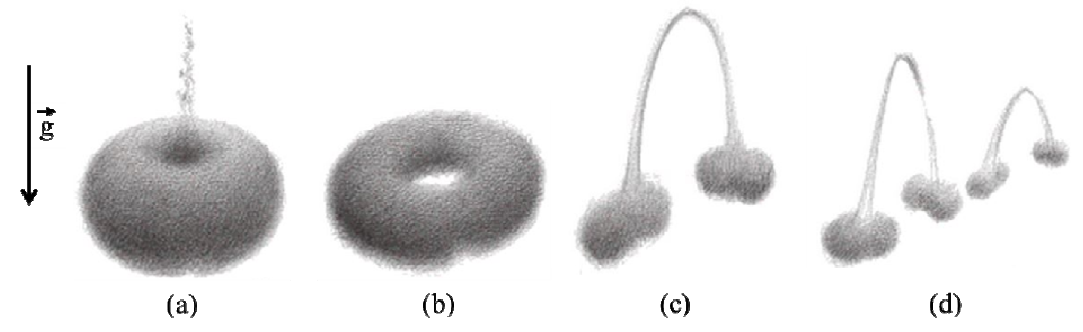
Figure 6. Four phases of particle cloud evolution during settling (adapted from [125]): ( a ) the initial acceleration phase; ( b ) the torus shape phase; ( c ) the break-up phase 1; ( d ) the break-up phase